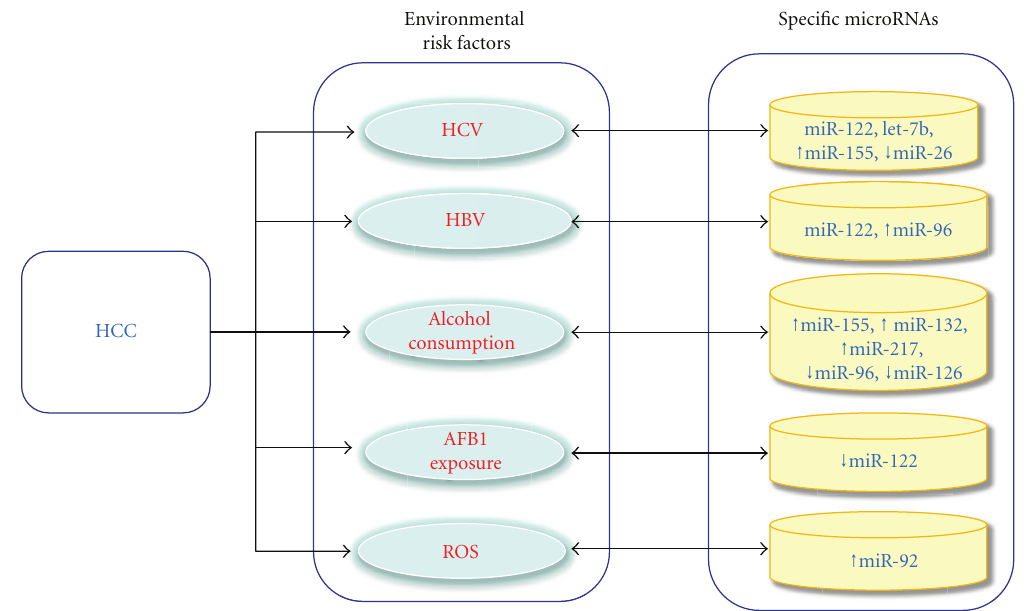
Figure 2: Specific miRNAs are associated with di ff erent subgroups of HCC associated with various environmental risk factors. ↑ indicates up-regulation; ↓ indicates down-regulation; HCC: hepatocellular carcinoma; HCV: hepatitis C virus; HBV: hepatitis B virus; AFB1: aflatoxin B1; ROS: reactive oxygen